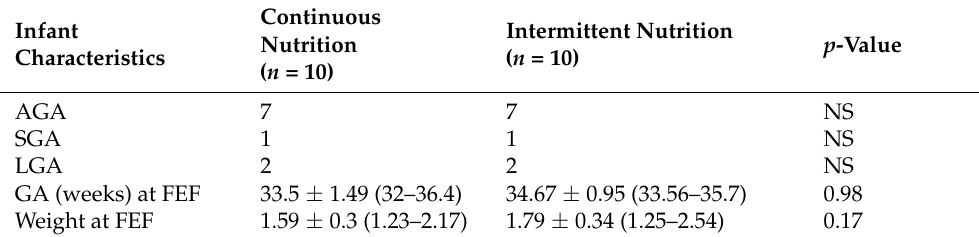
Table 1. Neonatal characteristics and duration of hypoglycemia based on CGM. AGA, appropriate for gestational age; SGA, small for gestational age; LGA, large for gestational age; GA, gestational age; FEF, full enteral feeding; NS, nonsignificant.